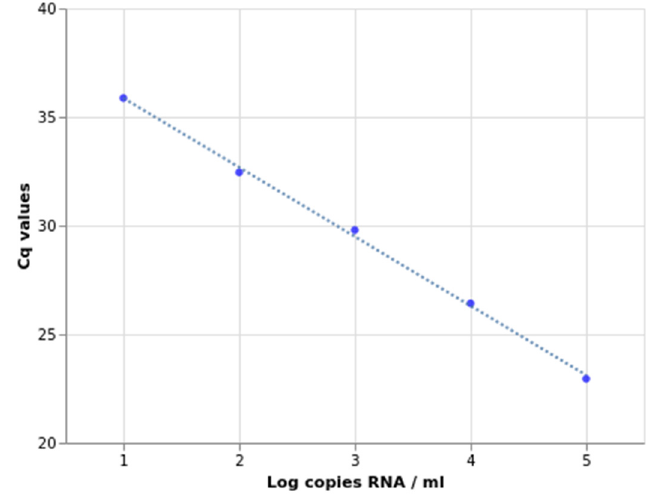
Figure A3. The effectiveness of the ERS31del qRT-PCR is 105%. The slope of the standard curve is − 3.20.